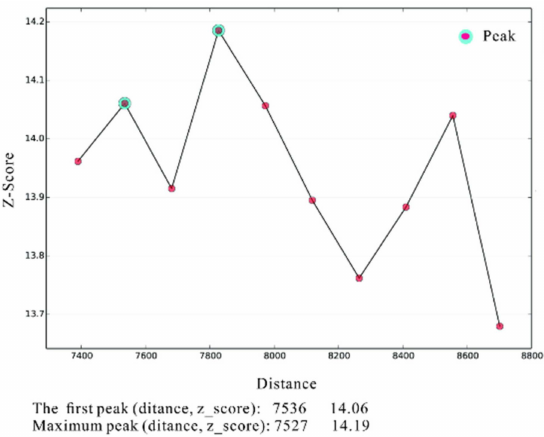
Figure 9. Incremental spatial autocorrelation line chart for the Boston housing